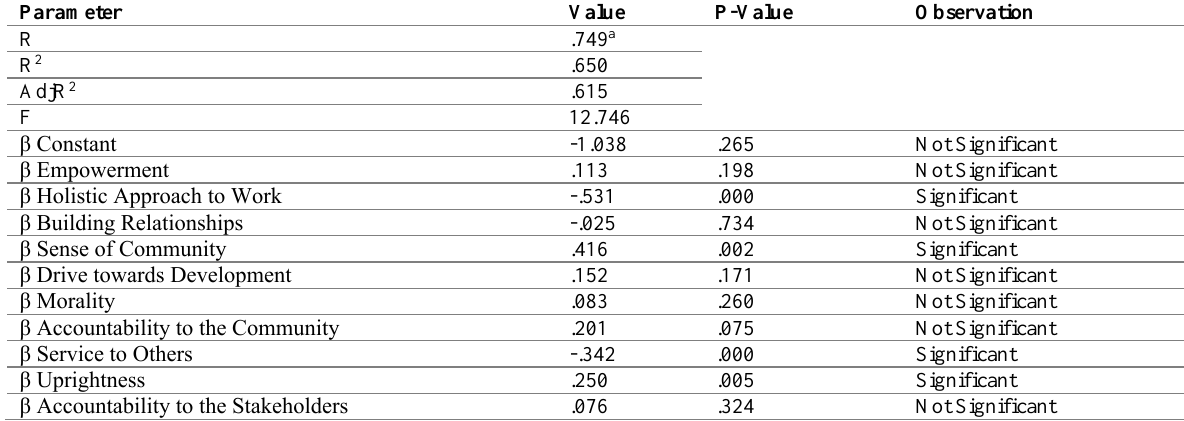
Table 5: Effect of Applicable